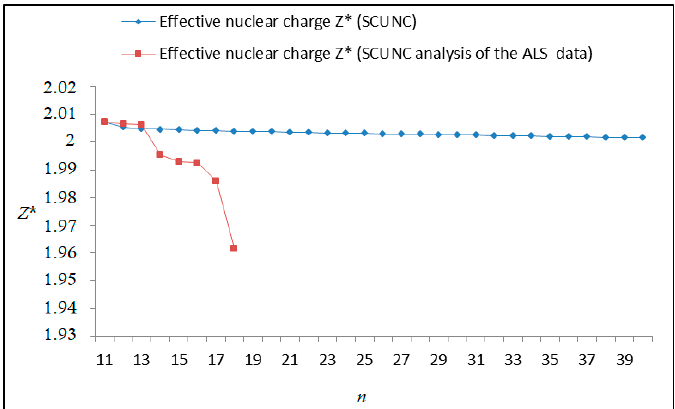
Figure 6. Variations of the effective nuclear charge Z* with the principal quantum number n for the 4 s 2 4 p 2 ( 3 P 2 ) nd Rydberg series originating from the 2 P ° 1/2 metastable state of Se + converging to the 3 P 2 series limits in Se 2+ . Table 4. Energy resonances ( E ), quantum defect ( δ ) and effective nuclear charge ( Z *) of the 4 s 2 4 p 2 ( 1 D 2 ) ns Rydberg series originating from the 4 s 2 4 p 3 2 P° 3/2 metastable state of Se + converging to the 1 D 2 series limit in Se 2+ . The present results (SCUNC) are compared with the experimental data from ALS measurements [6]. The uncertainties in the experimental energies are stated to be ±0.010 eV, f 1 ( 1 D 2 ; 2 P ° 3/2 ) = − 0.947